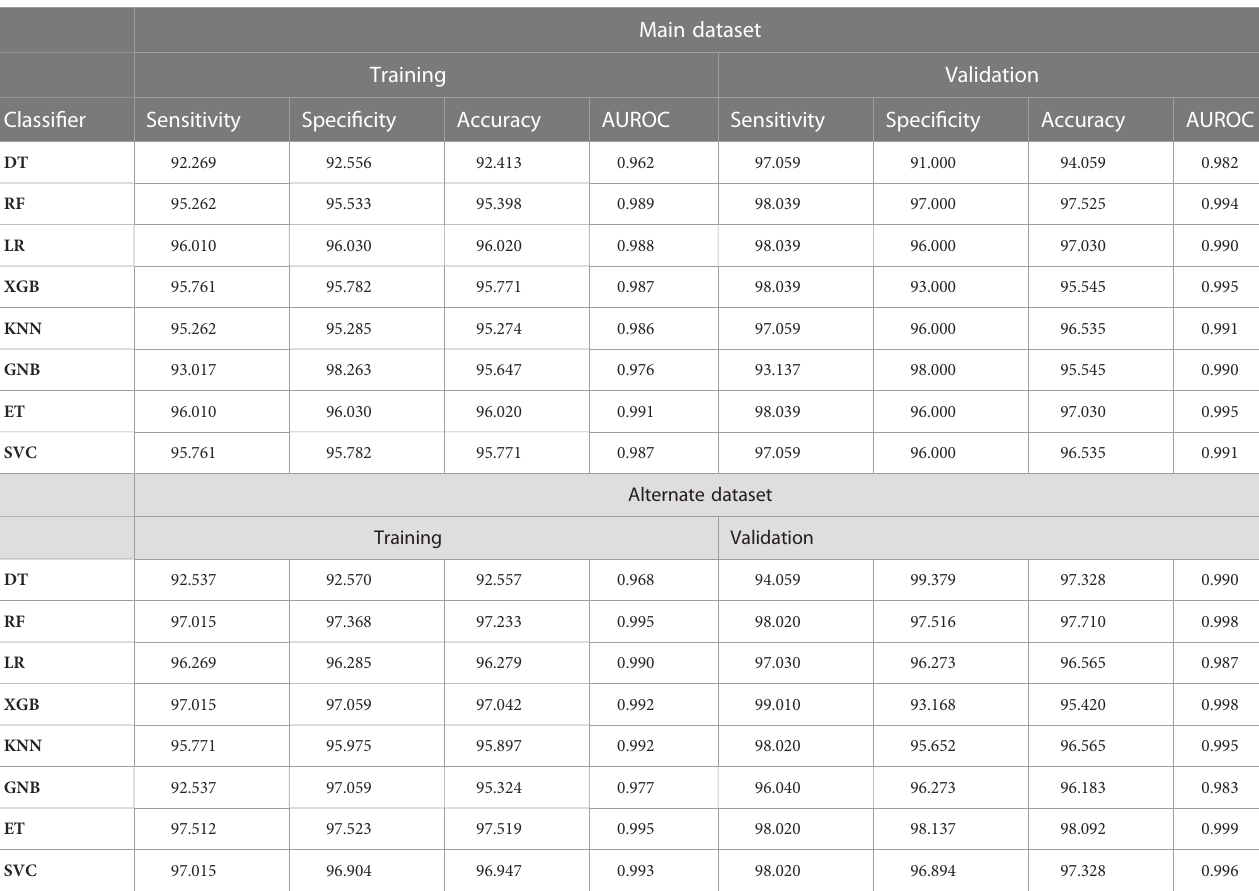
TABLE 4 The performance of machine learning classi fi ers on AAC based features on main and alternate